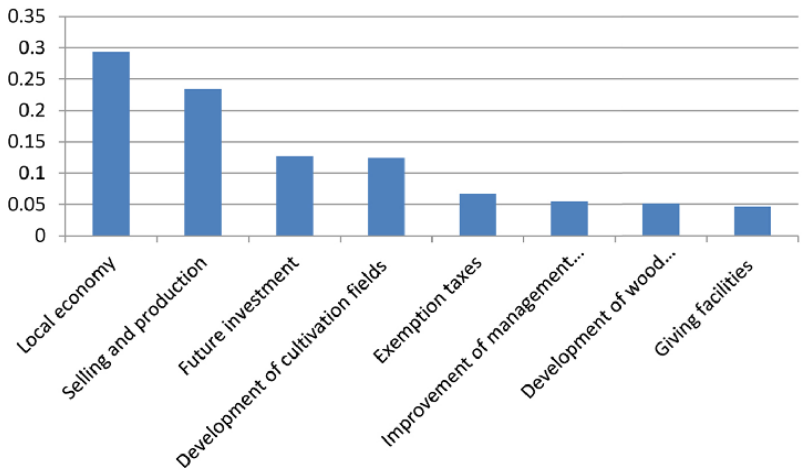
Figure 9: Final synthesis of opportunities indices (inconsistency rate 0.02), X: Criteria, Y: Weighing